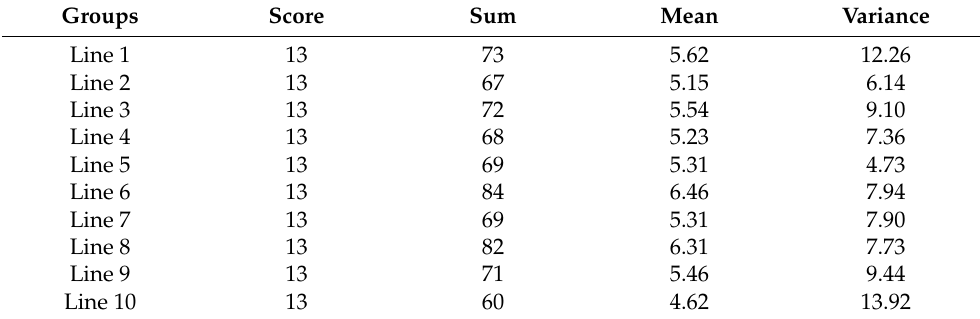
Table 5. One-way ANOVA.